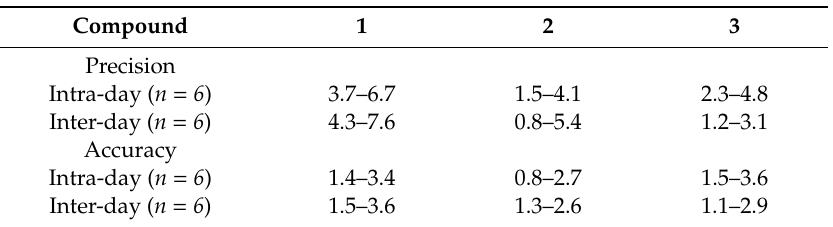
Table 3. Precision and accuracy data.